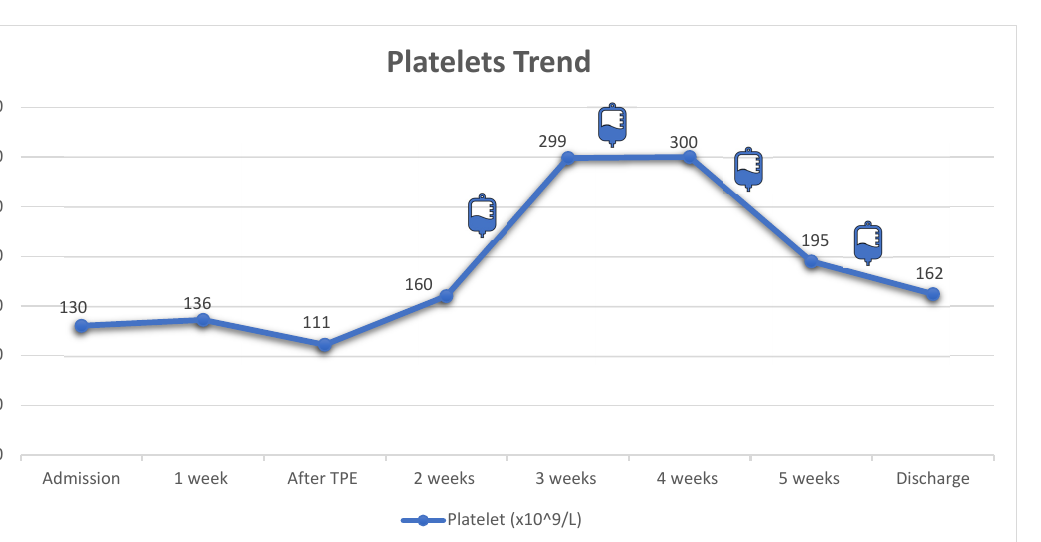
Figure 3. Trend of creatinine level during hospital course. The infusion bag icons correlate with the time of each rituximab dose. Rituximab resulted in a sustained improvement of all the hematologi- cal parameters (Figures 1 and 2), but there was no improvement in kidney function. 3. Discussion Since the beginning of the pandemic, millions of vaccines have been administered worldwide, which has resulted in a signi fi cant decline in COVID-19 morbidity and mor- tality [10]. Although all of the approved SARS-CoV-2 vaccines have proven to be e ff ective with tolerable local and systemic reactions such as pain, swelling, lymphadenopathy,